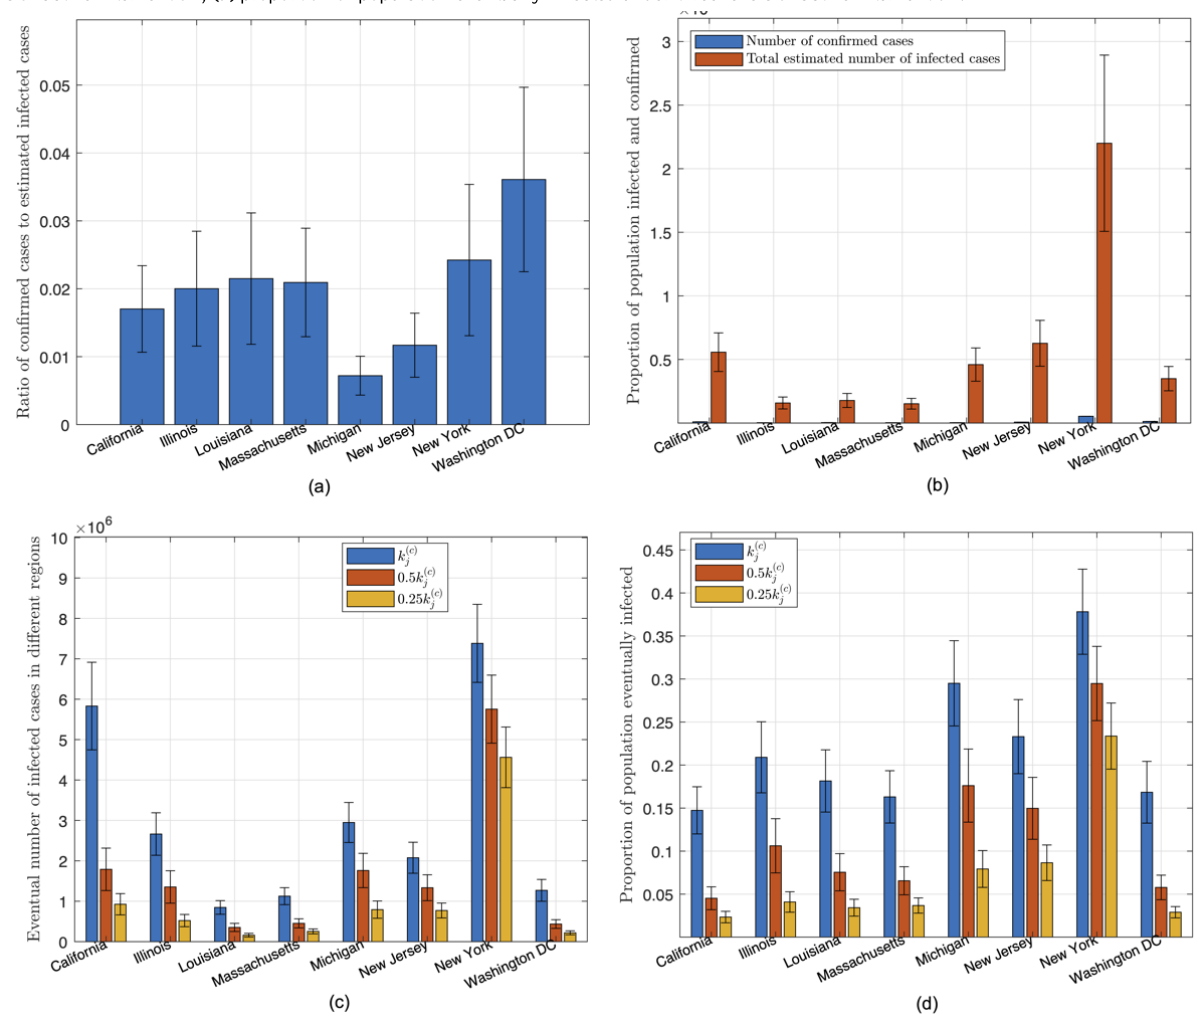
Figure 5. Statistics of data and predicted results for the United States. (a) Proportion of infected cases that are confirmed as of March 19, 2020; (b) number of confirmed cases and estimated number of infected cases as of March 19, 2020; (c) number of individuals eventually infected under three levels of active intervention; (d) proportion of population eventually infected under three levels of active